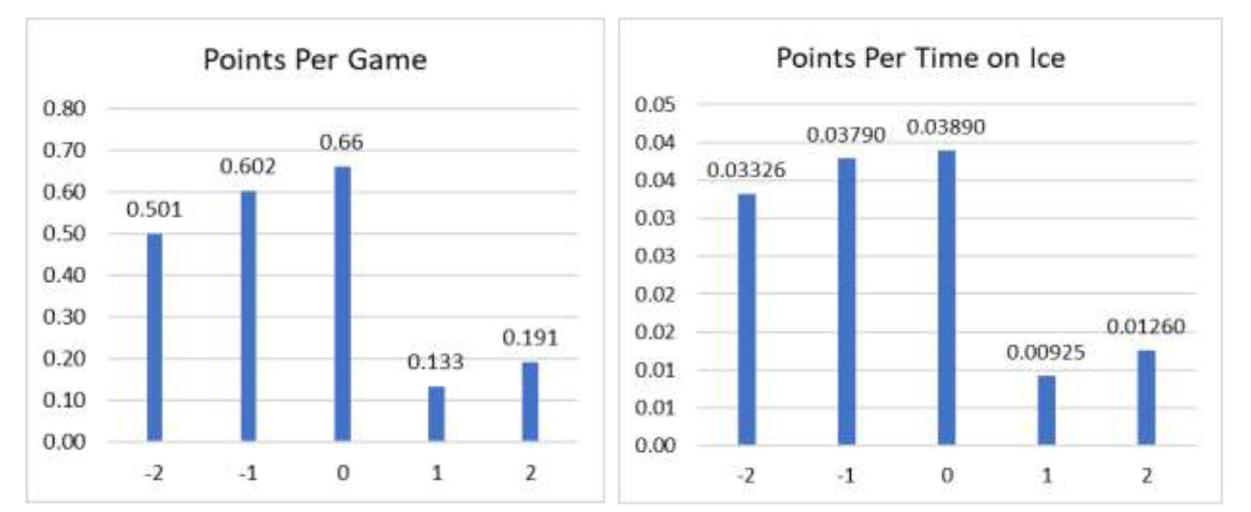
FIGURE 3 | NHL player performance in rookie contract years and first-non-rookie years: 2008–2019. Source: Hurley (2019).